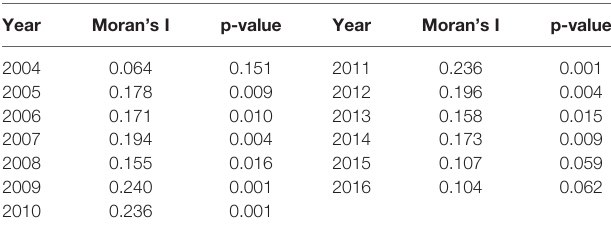
TABLE 6 | Moran ’ s I index of coastal marine pollution in coastal cities.